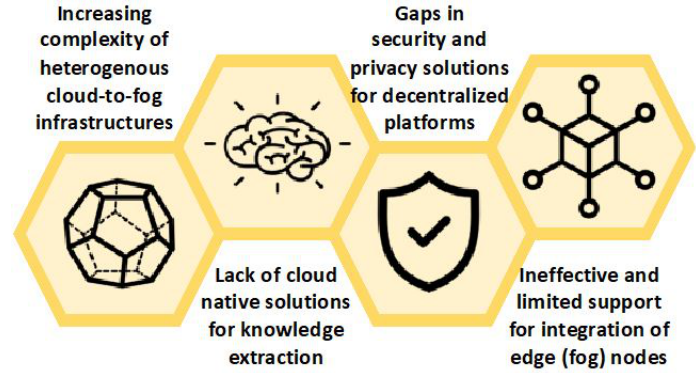
Figure 1. Current challenges in hybrid clouds for data-intensive IoT